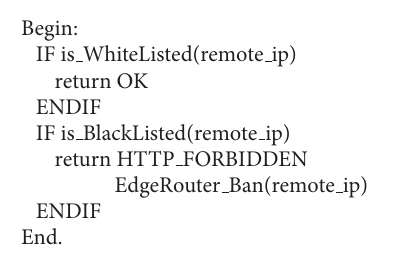
on the high rate attack entropy algorithm, as is shown in Algorithm 7.